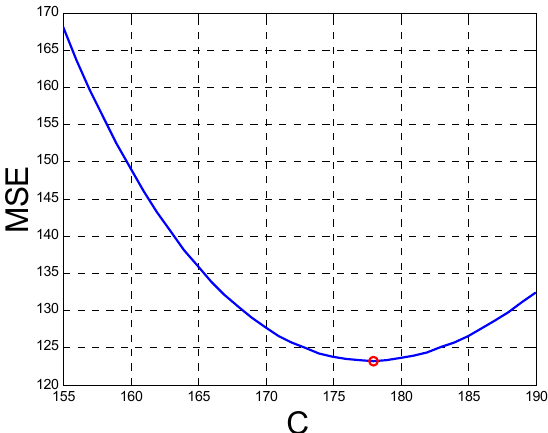
Figure 10. MSE values obtained when Formula (7) is used to identify α and C parameters.